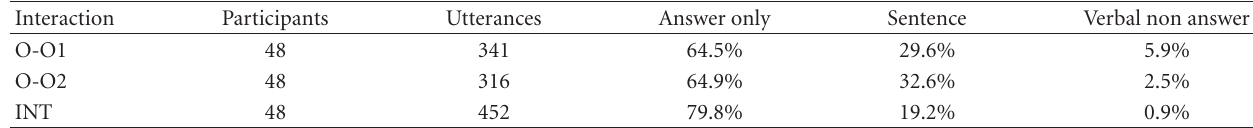
Table 2: Response type.